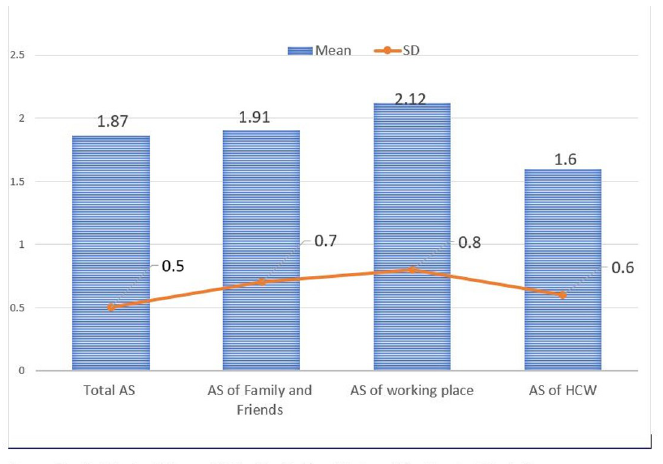
Fig 1. Anticipated stigma